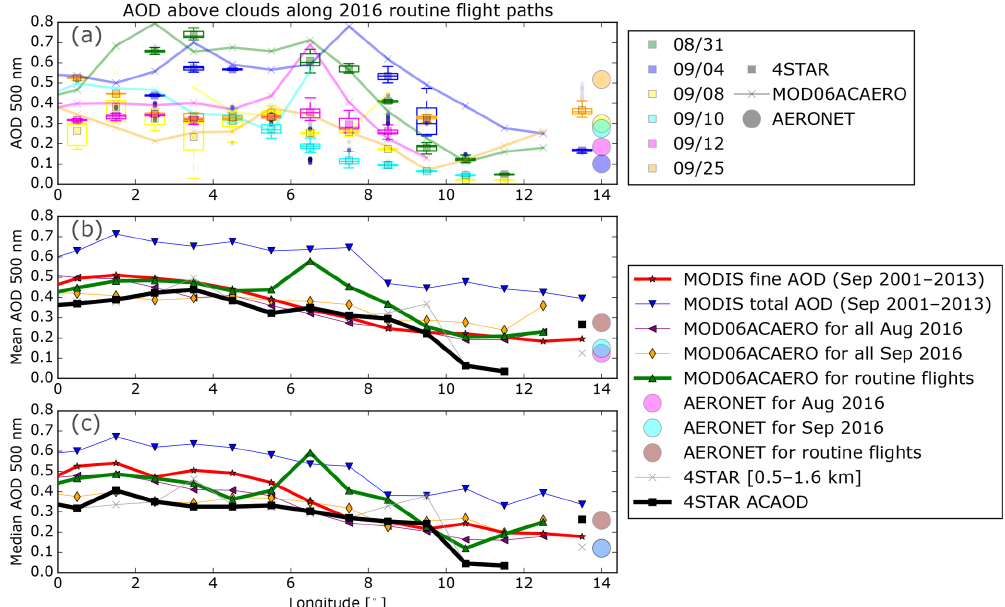
Figure 9. ACAOD at 501nm along the diagonal routine flight path (13 ◦ E 23 ◦ S to 0 ◦ E 10 ◦ S) for ORACLES 2016 compared to a MODIS climatology, MOD06ACAERO (aerosol above clouds retrieved from MODIS satellites; Meyer et al., 2015) retrievals as a function of longi- tude, and nearby ground-based AERONET fine-mode AOD. (a) The 4STAR ACAOD sampled during the days when the NASA P-3 followed the routine flight path and its equivalent retrievals from MOD06ACAERO. The 4STAR ACAOD is represented by box-and-whisker plots, for binned longitudes, whereas the MOD06ACAERO is represented by its mean value within a longitude by an “x” and connecting line. The AERONET fine-mode AOD measured from the DRAGON network at Henties Bay, Namibia, for the same days are presented in the far right of (a–c) as circles. (b) The mean of the ACAOD sampled over the days listed in (a) for 4STAR and MOD06ACAERO compared to other retrieved measurements over a longer time period. The monthly mean MOD06ACAERO for August and September 2016 along with the clear-sky mean total and fine-mode AOD from MODIS from September averaged over the years 2001–2013. The mean AOD from 4STAR sampled within the altitude range of 0.5–1.6km. (c) Median ACAOD instead of